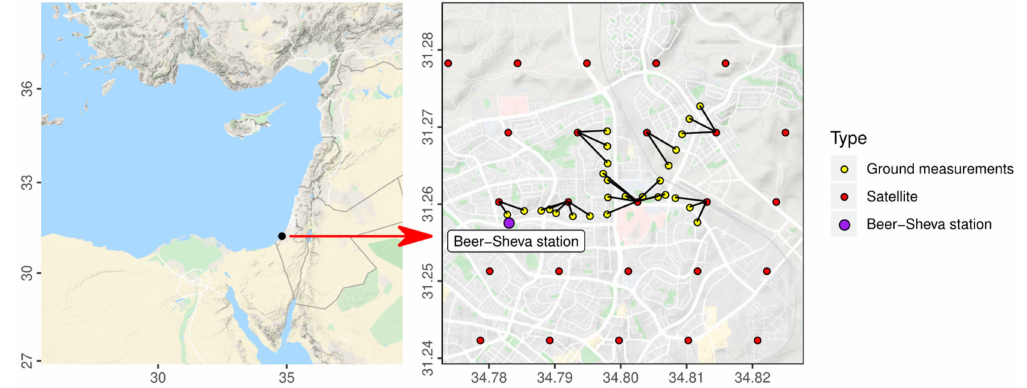
Figure 1. A map of the study site and the 28 mobile measurement points, along with the location of the monitoring